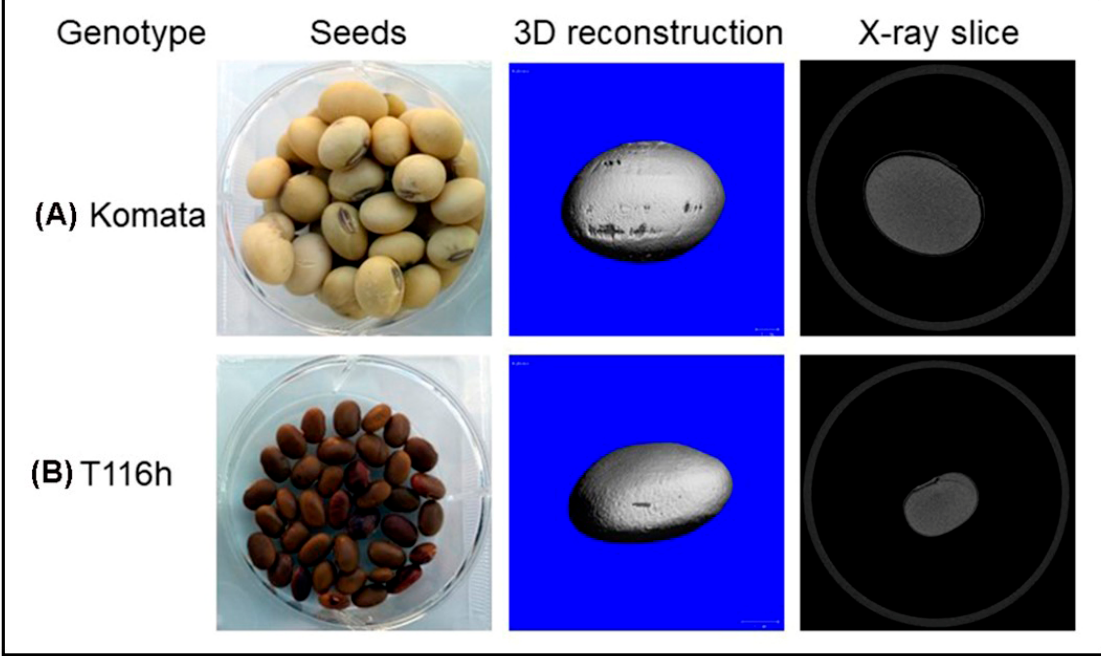
Figure 3. Sample images of the seeds of two contrasting soybean cultivars ( A , B ) after scanning with X-ray micro-computed tomography (micro-CT).